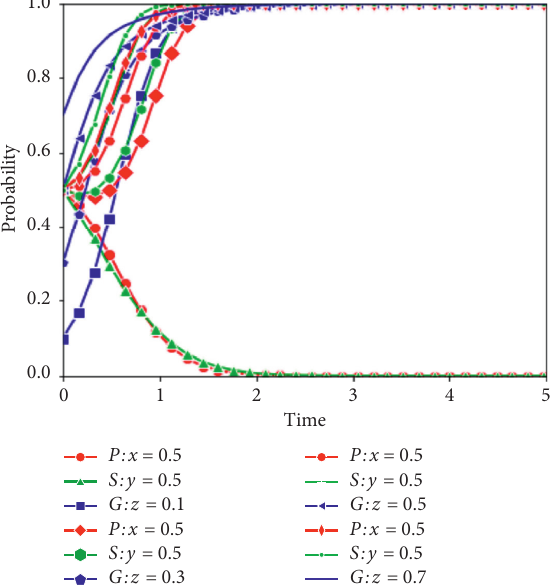
Figure 4: Dynamic evolution process of the tripartite game sub- jects when z